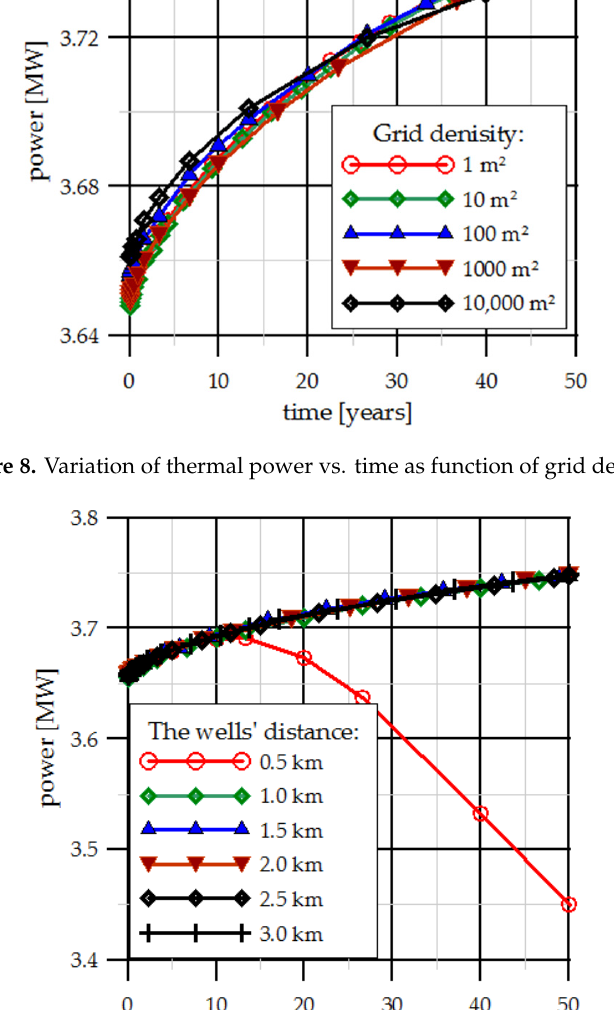
Table 2. Average amount of energy produced annually (TJ/yr) and averaged thermal power of the geothermal doublet—results in analyzed variants.